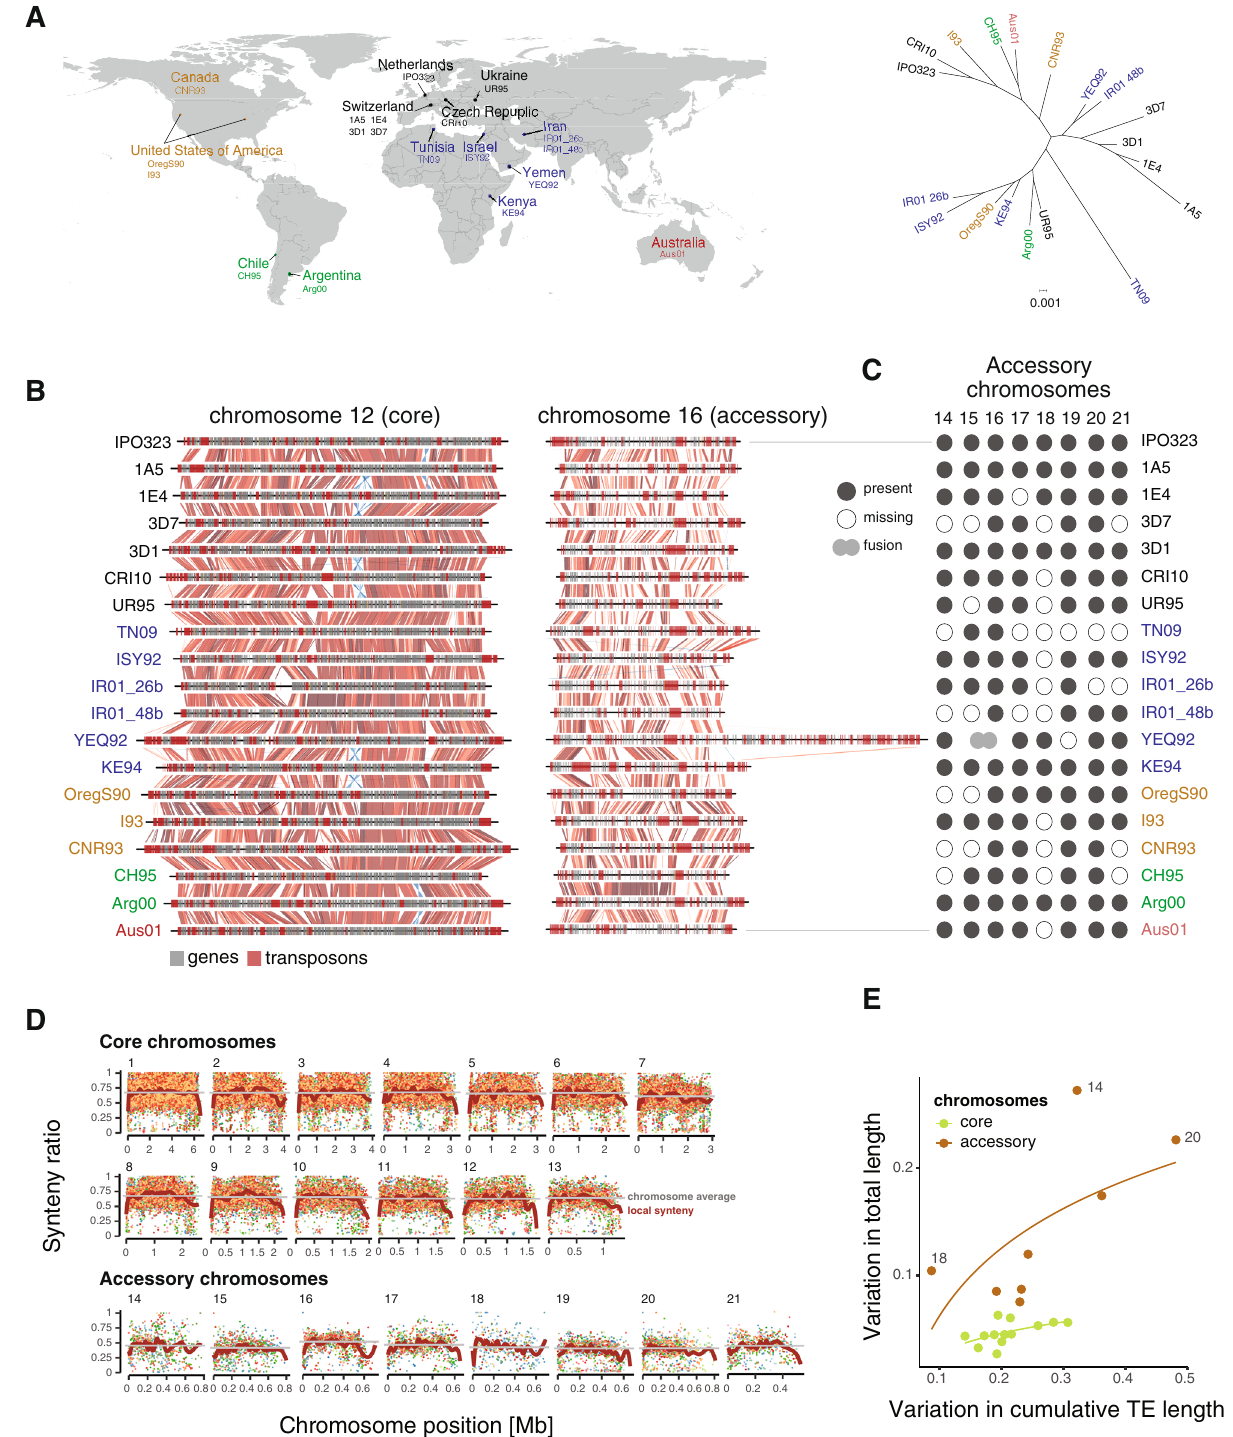
Fig. 1 Species-wide genome structure of a highly polymorphic microbial eukaryote. A Worldwide map showing the country of origin of the 19 Zymoseptoria tritici isolates and phylogenetic relationships based on 50 random orthologous genes. Colors indicate the continent of origin. The map was generated using the R package rworldmap. B Synteny plot of core chromosome 12 and accessory chromosome 16. The red and blue gradients represent the percentage of identity given BLAST alignments for syntenic and inverted segments, respectively. Darker colors show higher identity values. Genes and transposons are represented by gray and red boxes, respectively. C Presence/absence variation of accessory chromosomes. The isolate from Yemen (YEQ92) carries a hybrid chromosome following a fusion between chromosomes 15 and 16. D Genome-wide synteny ratios along chromosomes of the 19 isolates. Synteny ratios are shown for each isolate as represented by the colored dots. E Variation in the total transposable element (TE) content per chromosome. Core and accessory chromosomes are shown in green and brown, respectively. Length variation is expressed as the coef fi cient of variation. Curves show the best logarithmic fi